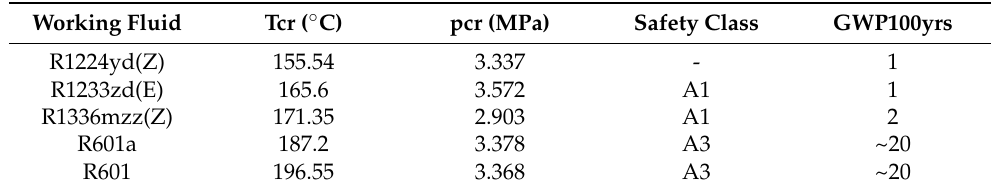
Table 1. Physical and environmental properties of the selected working fluids. Working Fluid